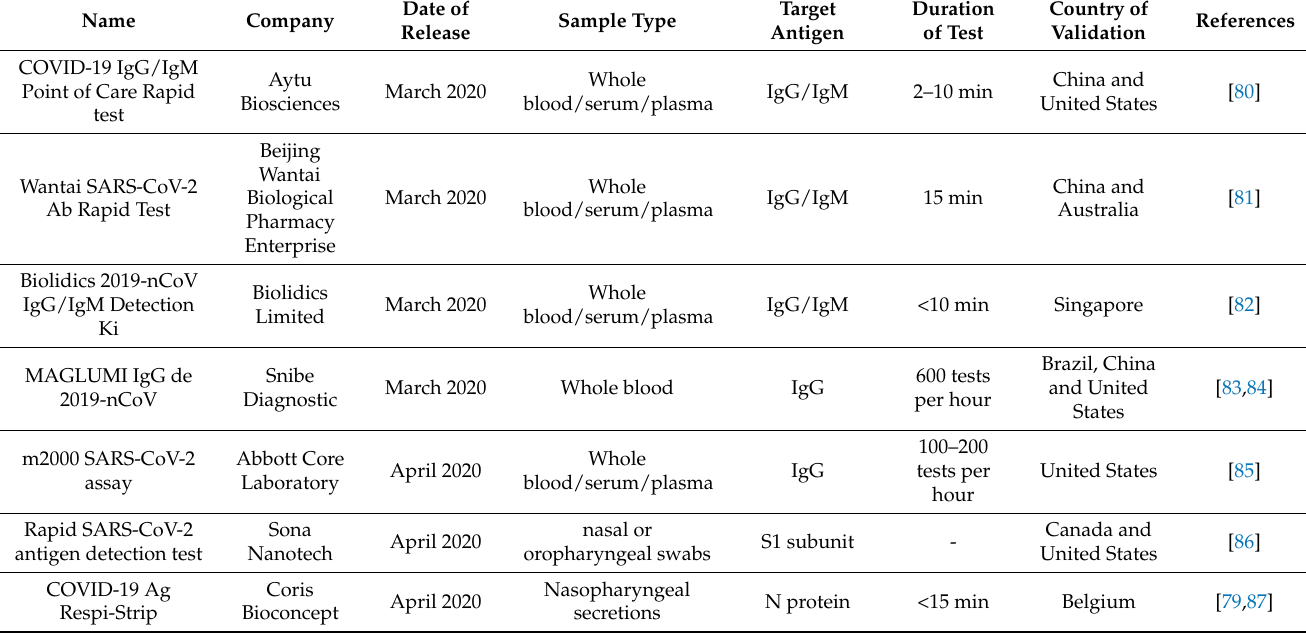
Table 3. Recently developed COVID-19 test kits and their